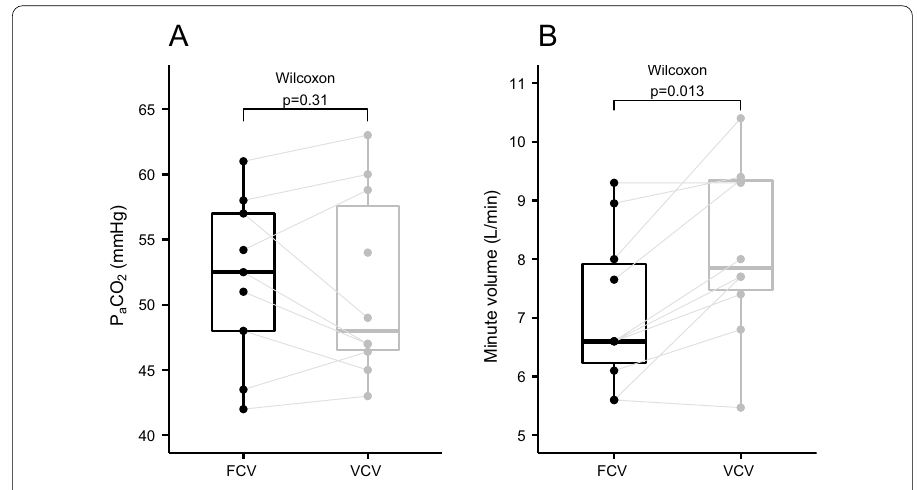
Fig. 3 Boxplots of PaCO2 ( A ) and minute volume ( B ) during FCV and VCV. Identical subjects are connected with grey lines. Groups were compared with the paired Wilcoxon signed-rank test. FCV flow-controlled ventilation, PaCO2 arterial partial pressure of carbon dioxide, VCV volume-controlled ventilation